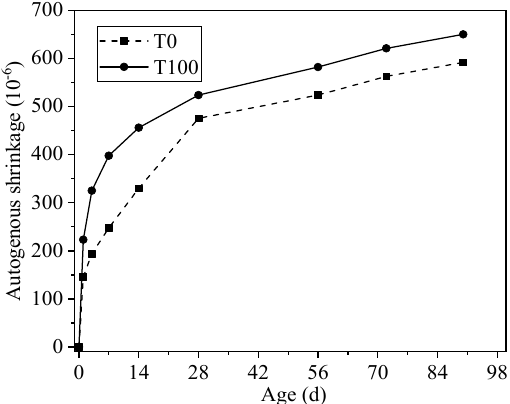
Figure 6. Autogenous shrinkage of concrete with iron tailings sand and river sand.